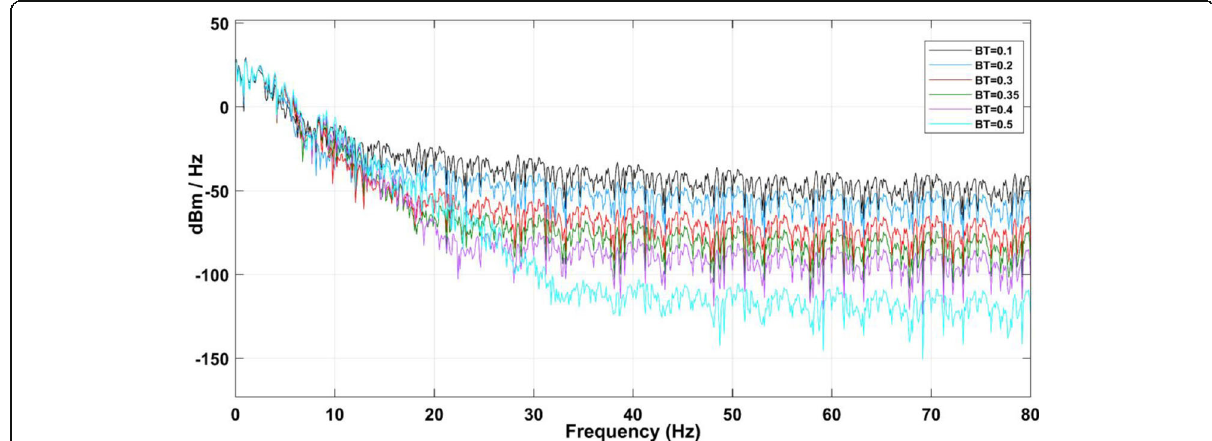
Fig. 2 Power spectral density: the power spectral density of GMSK signal. Lines of different colours represent different BT